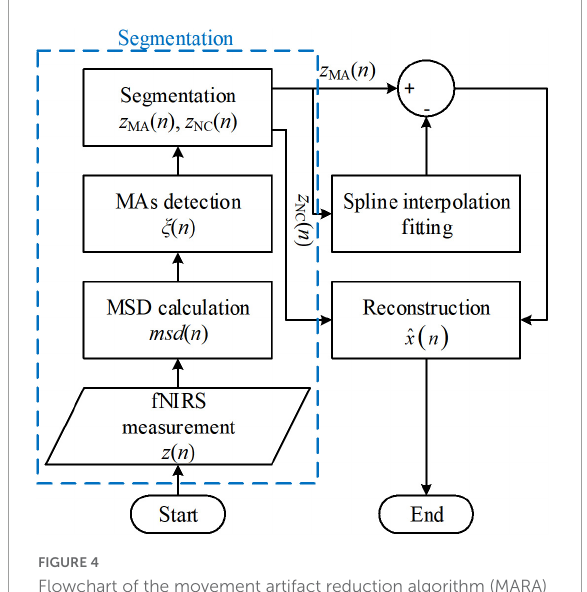
FIGURE4 Flowchart of the movement artifact reduction algorithm (MARA) algorithm. The process blocks in the blue box are one of the reasons that limit the solution’s online application.